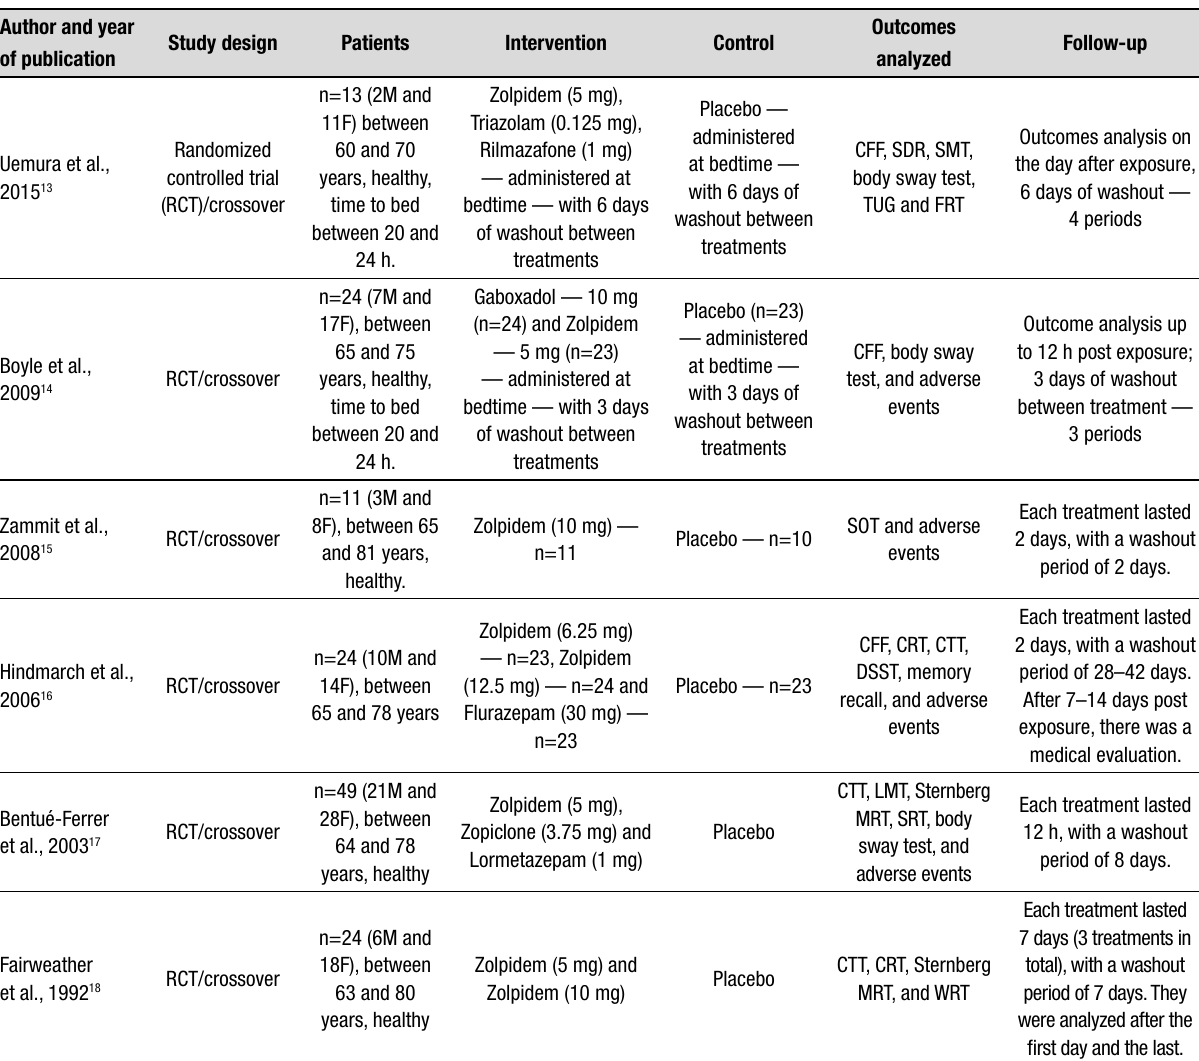
Table 1. Baseline characteristics of the included studies.